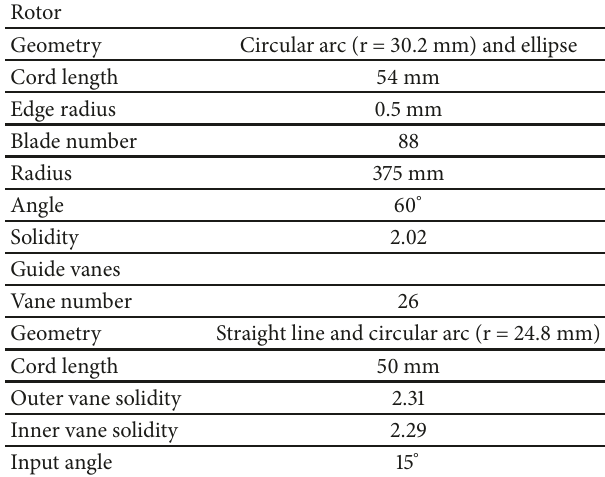
Table 3: Parameters of the impulse turbine. Table 4: Parameters of the radial